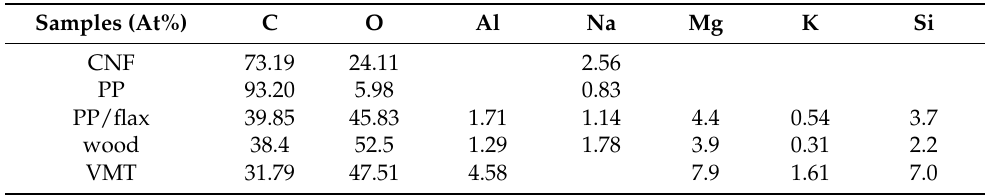
Figure 5. Elemental analysis spectroscopy of the coatings ( a ) before burn test and ( b ) after burn test. Table 1. Elemental analysis before burn test.